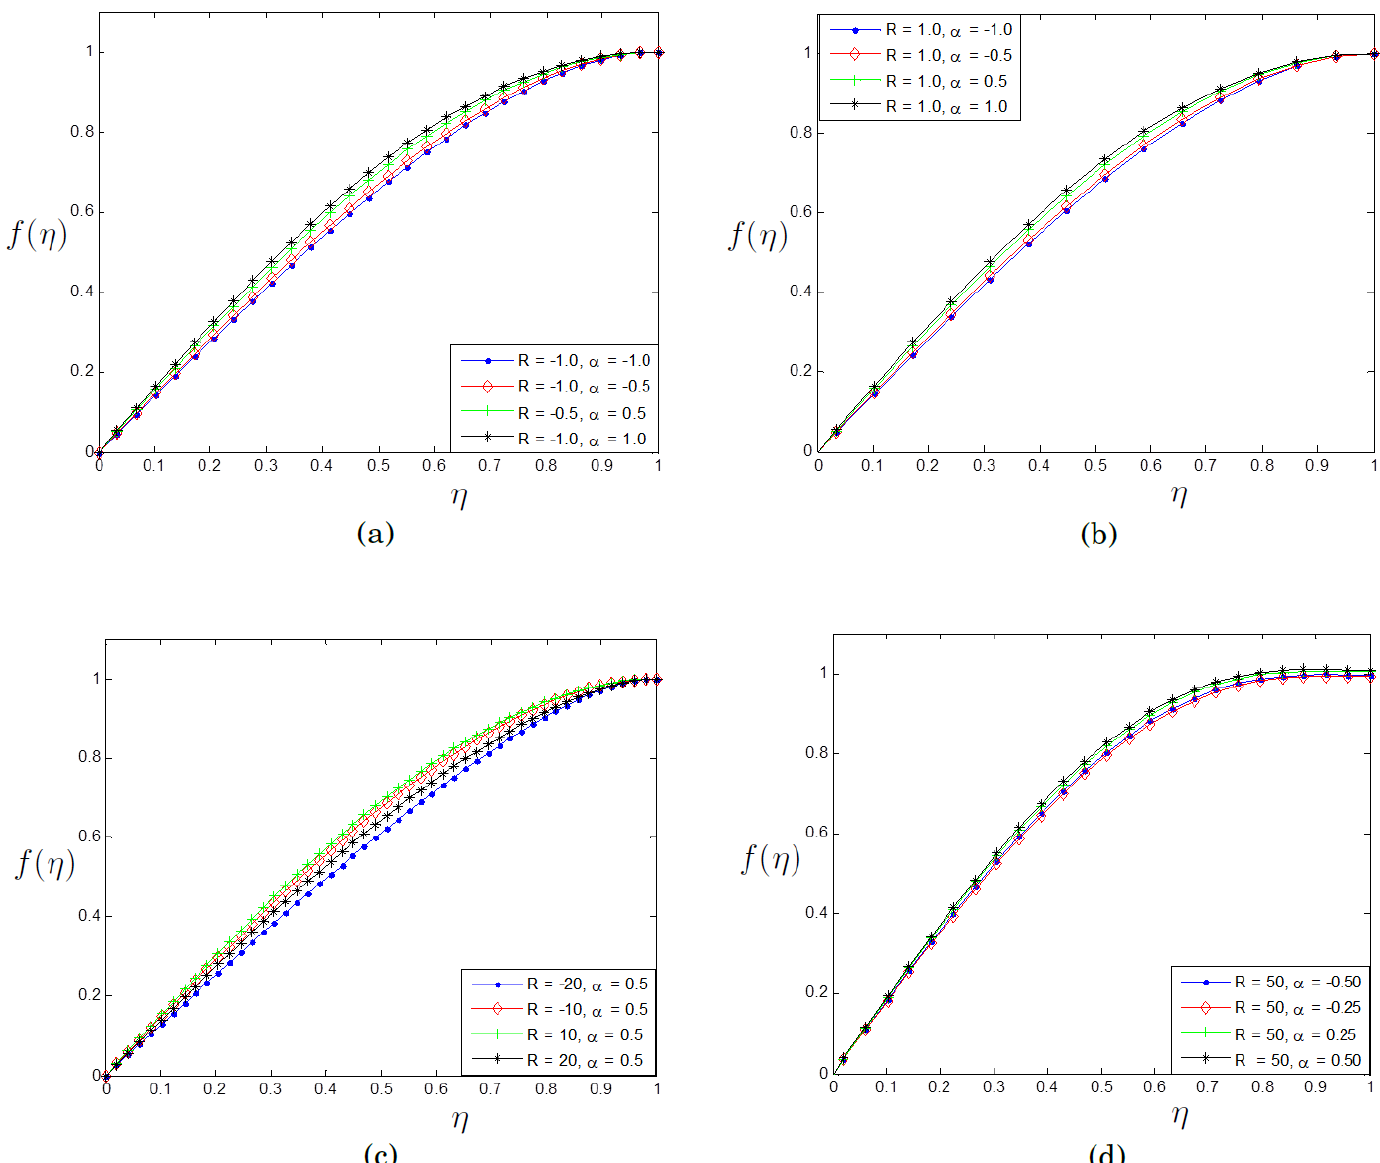
Figure 1: Variation of f ( η ) for different expansion and contraction ratio, α and different small values of Reynold number. Table 1: Comparison of the results concerning the flow for small Reynolds number for suction and expansion. f ( η ) Re = 5.0, α = 0 .